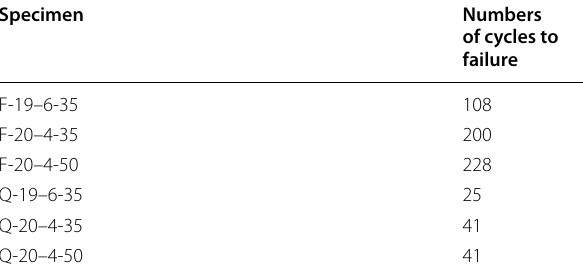
Table 3 Fatigue lives of the tested USS specimens Specimen Numbers